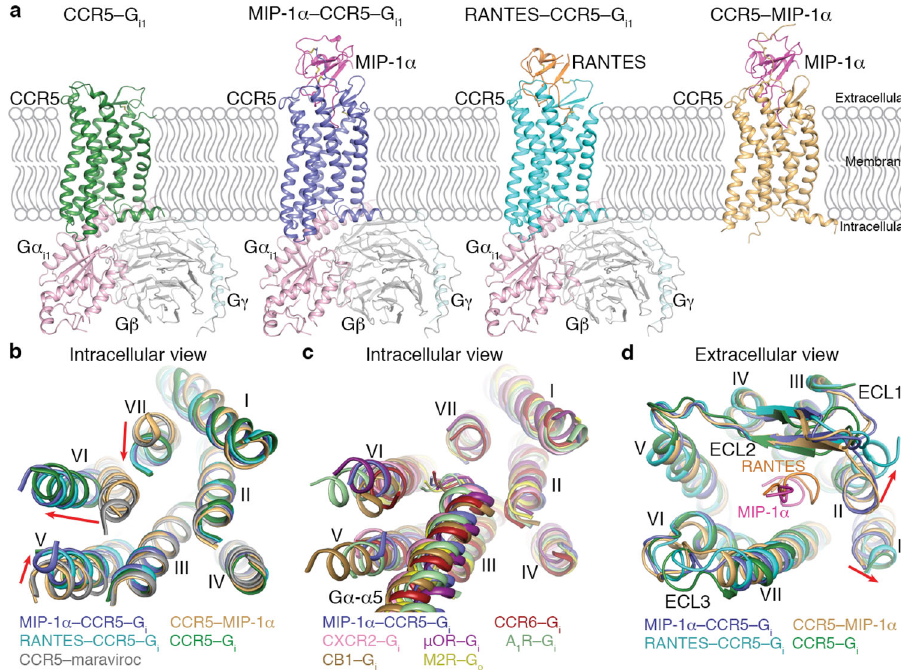
Fig. 1 Overall structures of the CCR5 – chemokine and CCR5 – G i1 complexes. a Cryo-EM structures of CCR5 – G i1 , MIP-1 α – CCR5 – G i1 , and RANTES – CCR5 – G i1 and crystal structure of CCR5 – MIP-1 α . The structures are shown in cartoon representation. The receptor CCR5 in the four structures is colored green, blue, cyan, and gold, respectively. The chemokines MIP-1 α and RANTES are colored magenta and orange, respectively. The three subunits in G i1 are colored light pink, light gray, and light cyan, respectively. Disul fi de bonds are shown as yellow sticks. b Comparison of the transmembrane helical bundle conformation in the CCR5 structures. The helical bundles in the structures of CCR5 – G i1 , MIP-1 α – CCR5 – G i1 , RANTES – CCR5 – G i1 , and CCR5 – MIP-1 α and the previously determined structure of CCR5 – maraviroc (PDB ID: 4MBS) are colored green, blue, cyan, gold, and gray, respectively. The red arrows indicate the movements of the intracellular tips of helices V, VI, and VII in the G i1 -bound CCR5 structures compared to those in the structures of CCR5 – MIP-1 α and CCR5 – maraviroc. c Comparison of the G protein-binding pocket in the structures of MIP-1 α – CCR5 – G i1 and other class A GPCR – G i/o complexes. The helical bundles and the C termini of G α α 5-helix in the MIP-1 α – CCR5 – G i1 structure and the structures of CCR6 – G i , CXCR2 – G i , μ OR – G i , A 1 R – G i , CB1 – G i , and